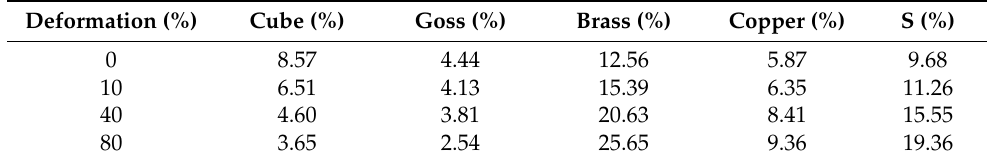
Table 1. Volume fractions of the textures in samples after different cold rolling treatments, calculated based on the ODF (with a measurement accuracy of